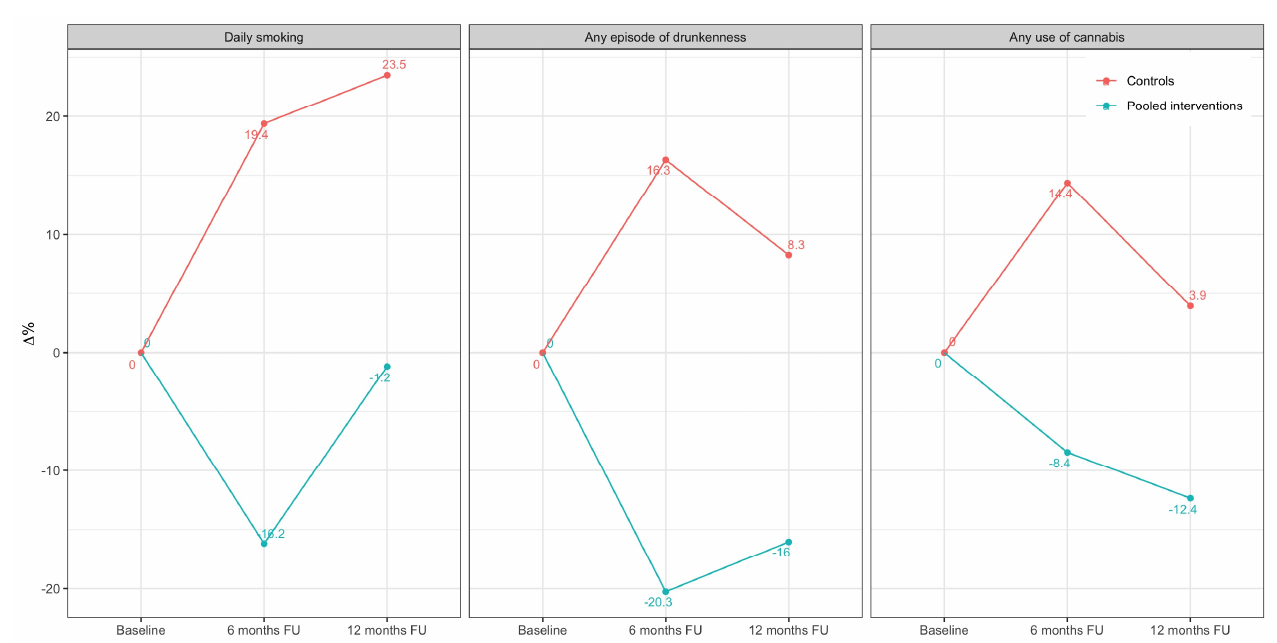
Figure 1. Changes in prevalence of past substance use between experimental and control groups at baseline, and at the 6-month and at the 12-month